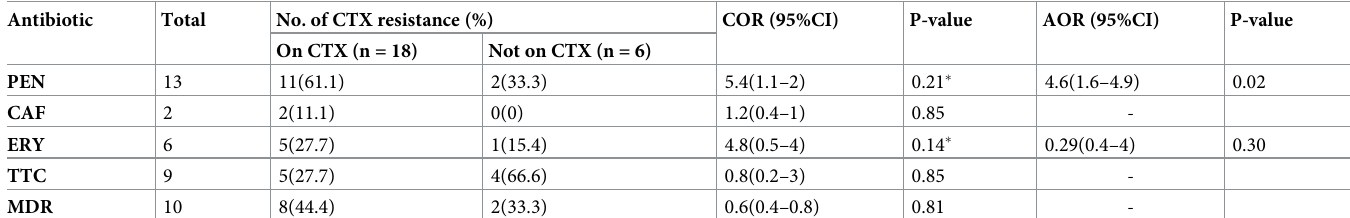
Table 4. Association of CTX resistance to other classes of drug co-resistance among pneumococci colonized study participants at Arba Minch, 2018: A multivariate logistic regression analysis. Antibiotic